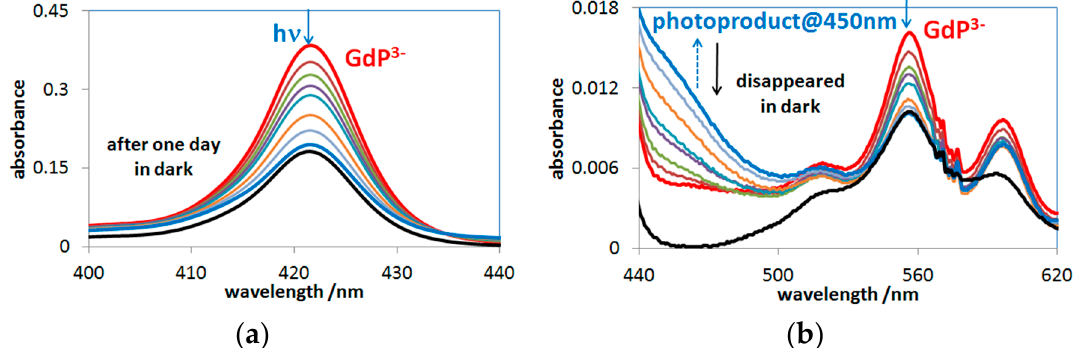
Figure 6. ( a ) Soret- and ( b ) Q-band spectral change during the 45-min Soret-band irradiation of gadolinium(III) porphyrin in the presence of 0.01 M NaAc, 9.2 × 10 –7 M H 2 TSPP 4– , 1.0 × 10 –3 M Gd 3+ , pH ≈ 6, I 0 (421 nm) = 1.2 × 10 –5 M photons/s, ℓ = 1 cm.